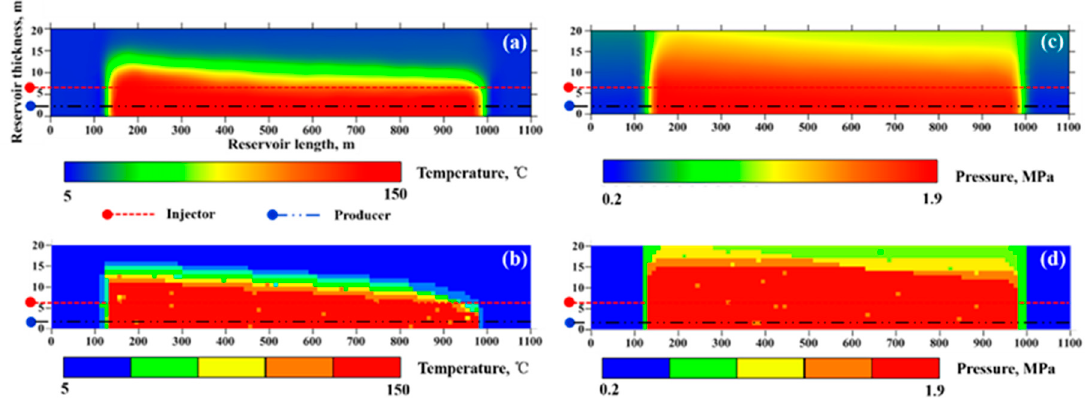
Figure 7. Comparison of the steam chamber and reservoir pressure profile along the well pair axis at the end of the circulation stage (vertical exaggeration 10 times): ( a ) steam chamber calculated by the developed model; ( b ) steam chamber simulated by CMG; ( c ) reservoir pressure profile calculated by the developed model; ( d ) reservoir pressure profile simulated by CMG.